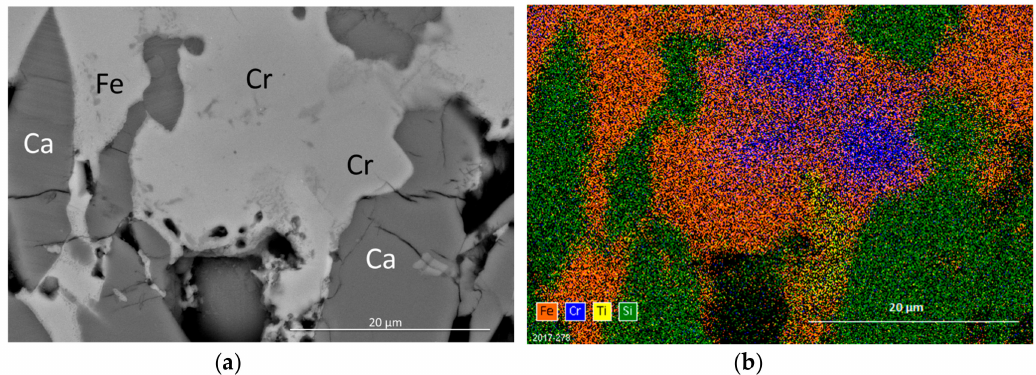
Figure 2. SEM-BSE image of CS slags. Ca = Ca(Al) silicates (larnite, gehlenite), Fe = Fe oxides (wustite, Fe spinel), Cr = Mg chromite. ( a ) BSE image of Fe-rich spinel with Cr-rich spinel inclusions in the matrix of Ca(Al) silicates. ( b ) Element distribution determined by EDX.